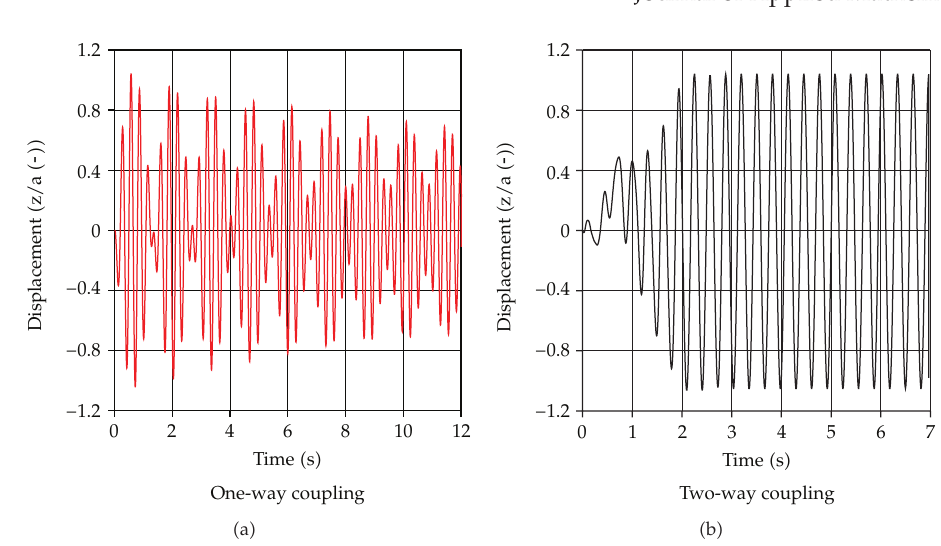
Figure 8: Displacement over time, v (cid:8) 0 . 34m/s, plate 1.